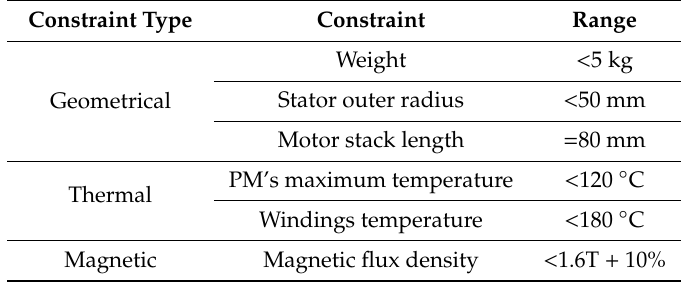
Table 7. Optimization constraints by type and respective